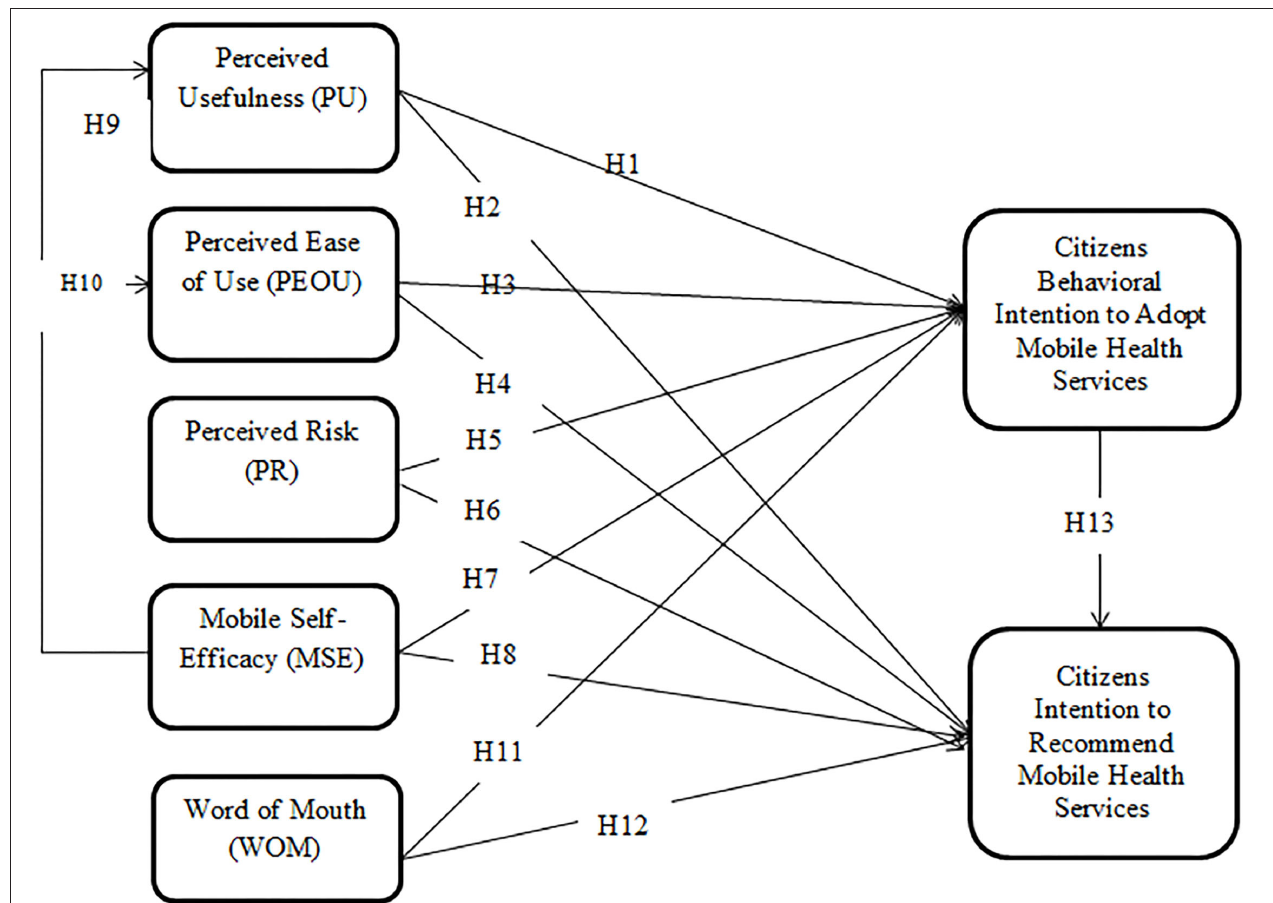
FIGURE 1 | Research